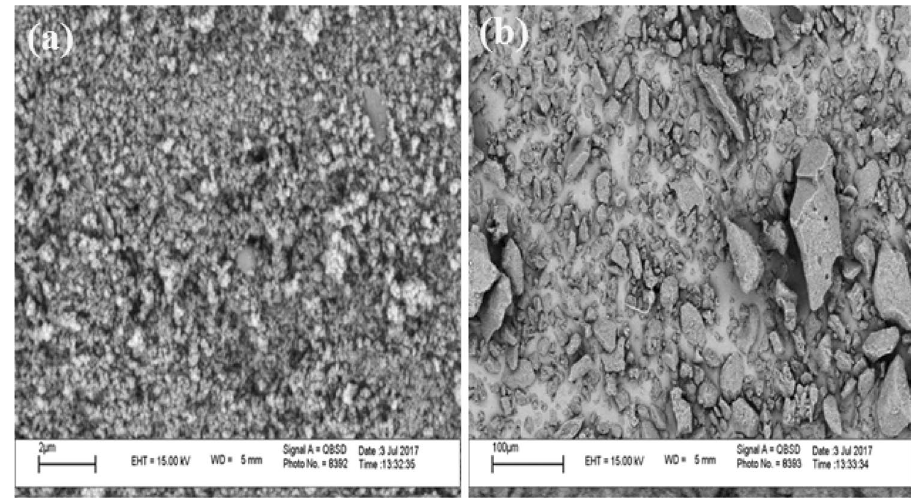
Fig. 2 SEM images of activated carbon before ( a ) and after the surface adsorption process ( b